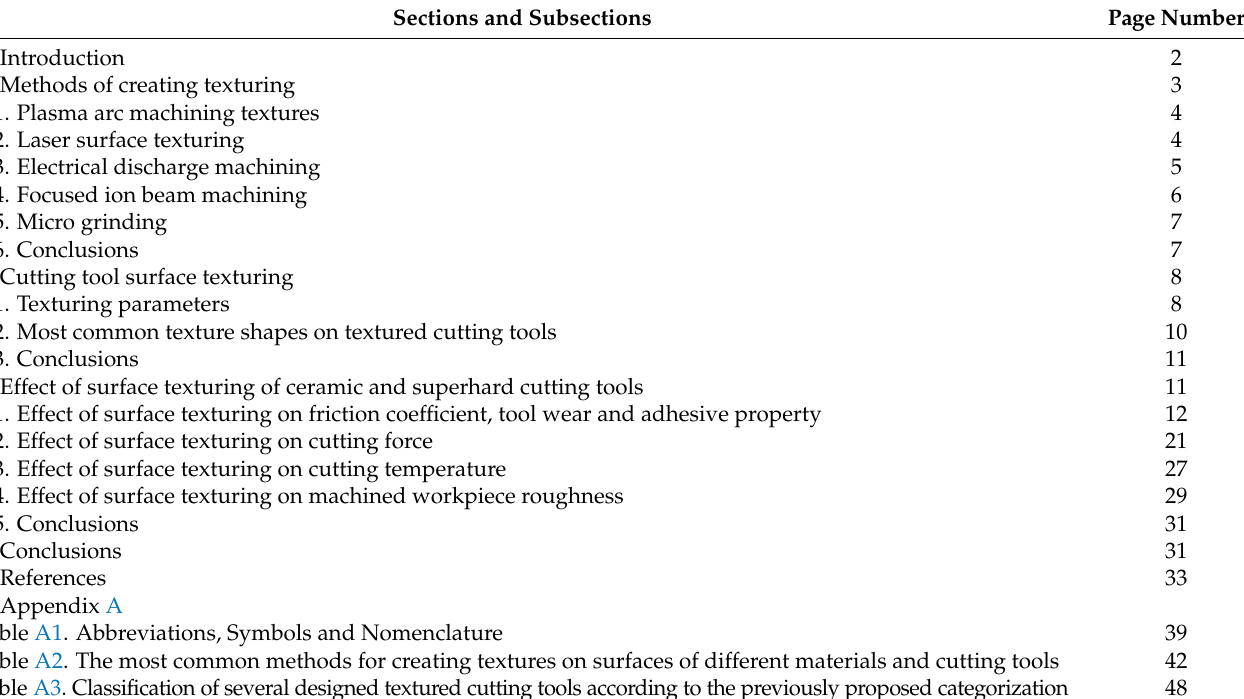
Table A2. The most common methods for creating textures on surfaces of different materials and cutting tools Table A3. Classification of several designed textured cutting tools according to the previously proposed